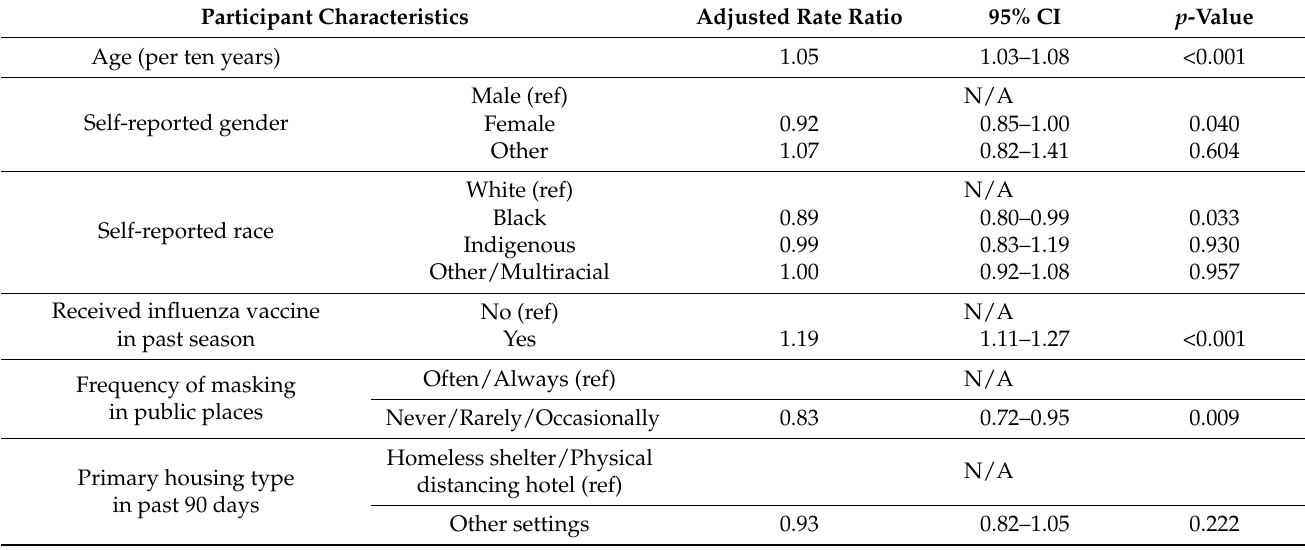
Figure 2. Cumulative incidence (and 95% Confidence Interval) of COVID-19 vaccination by dose number, among (1) Ku-gaa-gii pimitizi-win study participants having known vaccination dates, and (2) adult Torontonians overall. Table 2. Factors associated with COVID-19 vaccination (1 or more doses) among Ku-gaa-gii pimitizi- win participants with confirmed serology at baseline (June to September 2021) ( n =